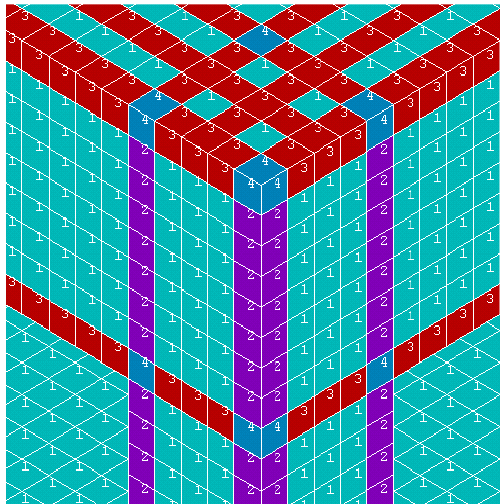
Figure 4. Defining Material Properties on Joints